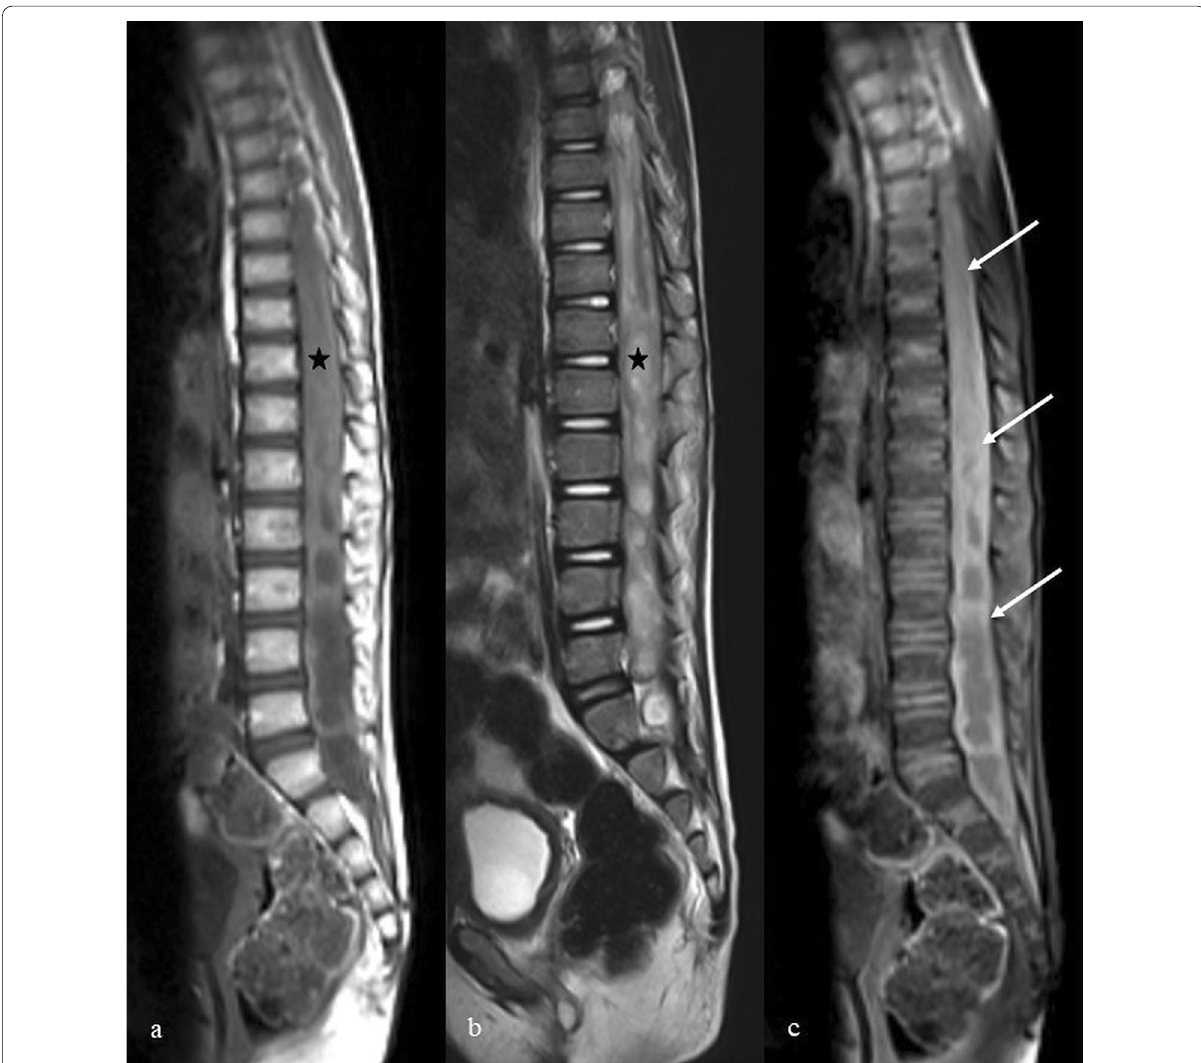
Fig. 3 Sagittal T1 ( a ), T2 ( b ), and T1 post-contrast ( c ) sequences show long segment T1 hypointense and T2 hyperintense signal abnormality in the thoracolumbar cord (asterisk). The corresponding patchy postcontrast enhancement extends inferiorly into the thecal sac